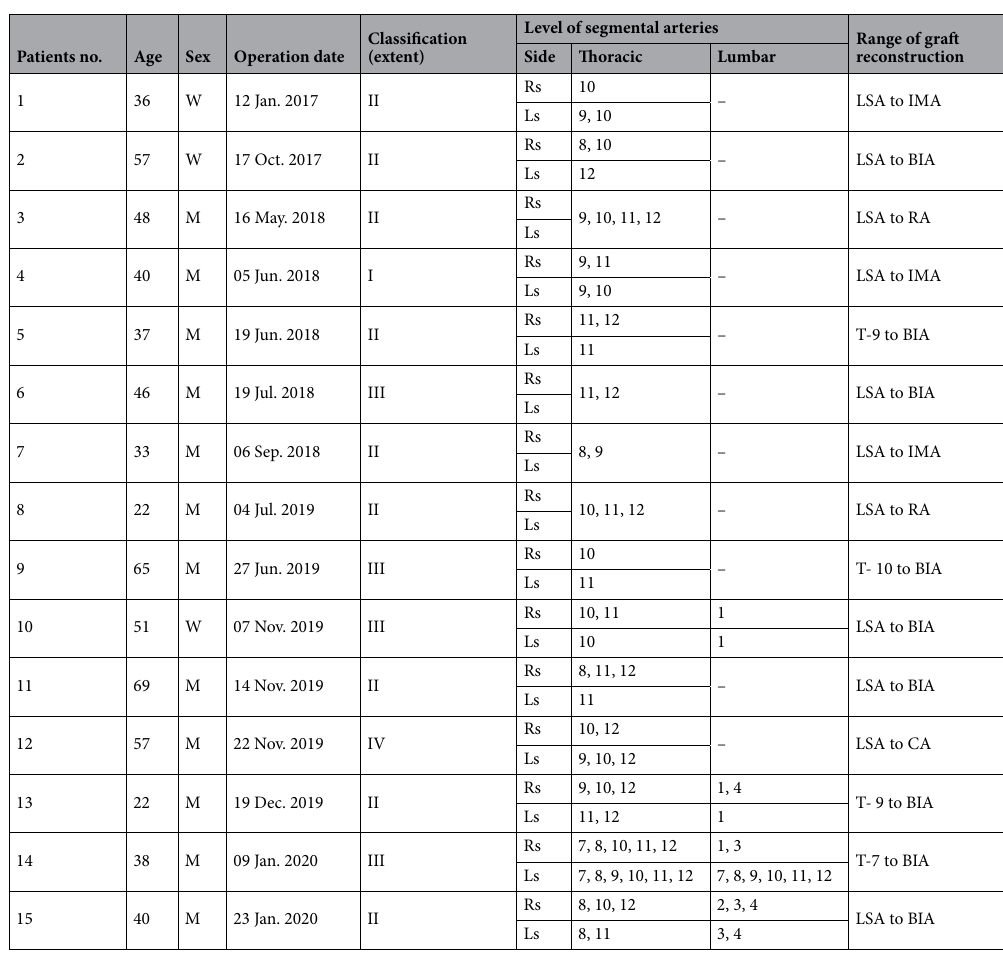
Table 1. Individual profiles of the subject patients including classification, level of segmental artery, and range of replacement. Rs right side, Ls left side, T thoracic, LSA left subclavian artery, IMA interior mesenteric artery, BIA bilateral common iliac artery, RA renal